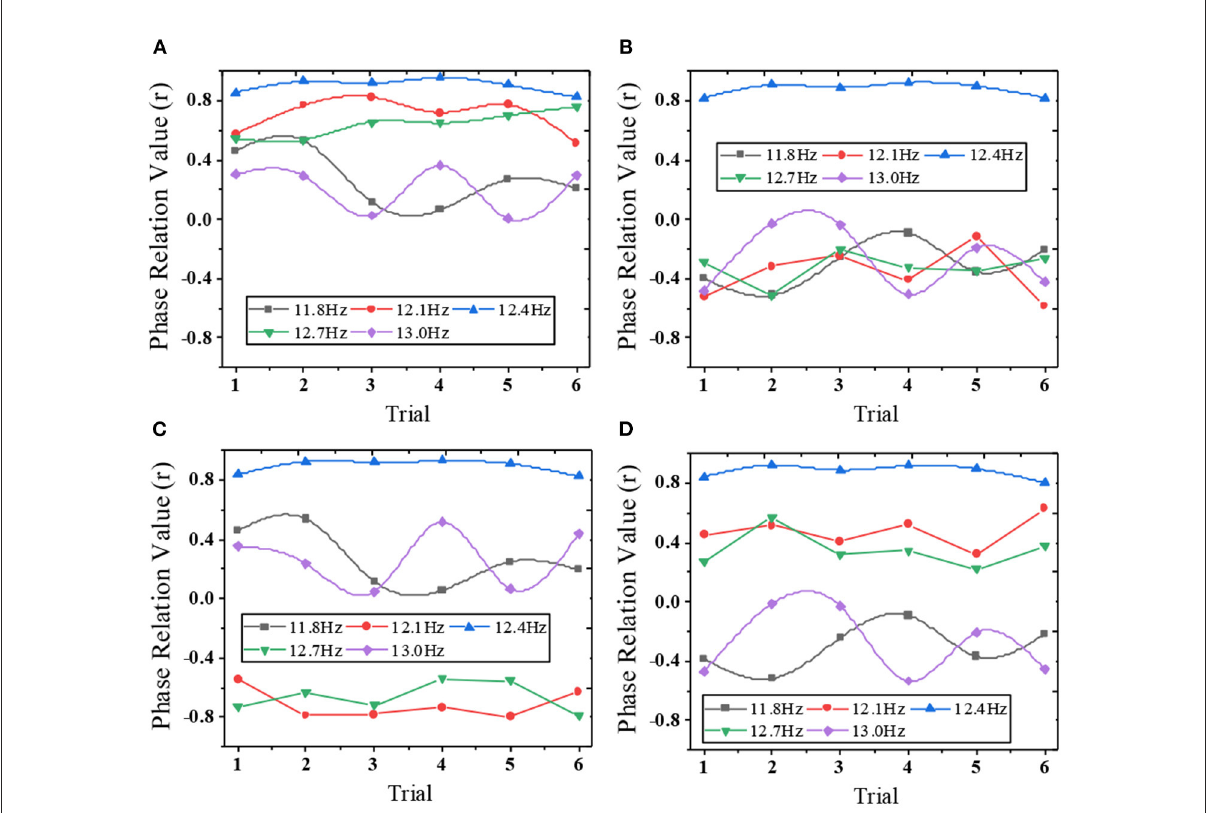
FIGURE6 Correlation coefficients between SSVEP and adjacent frequency for a single test at 12.4Hz [ (A) 1 φ = 0; (B) 1 φ = 0.5 π ; (C) 1 φ = π ; (D) 1 φ = 1.5 π